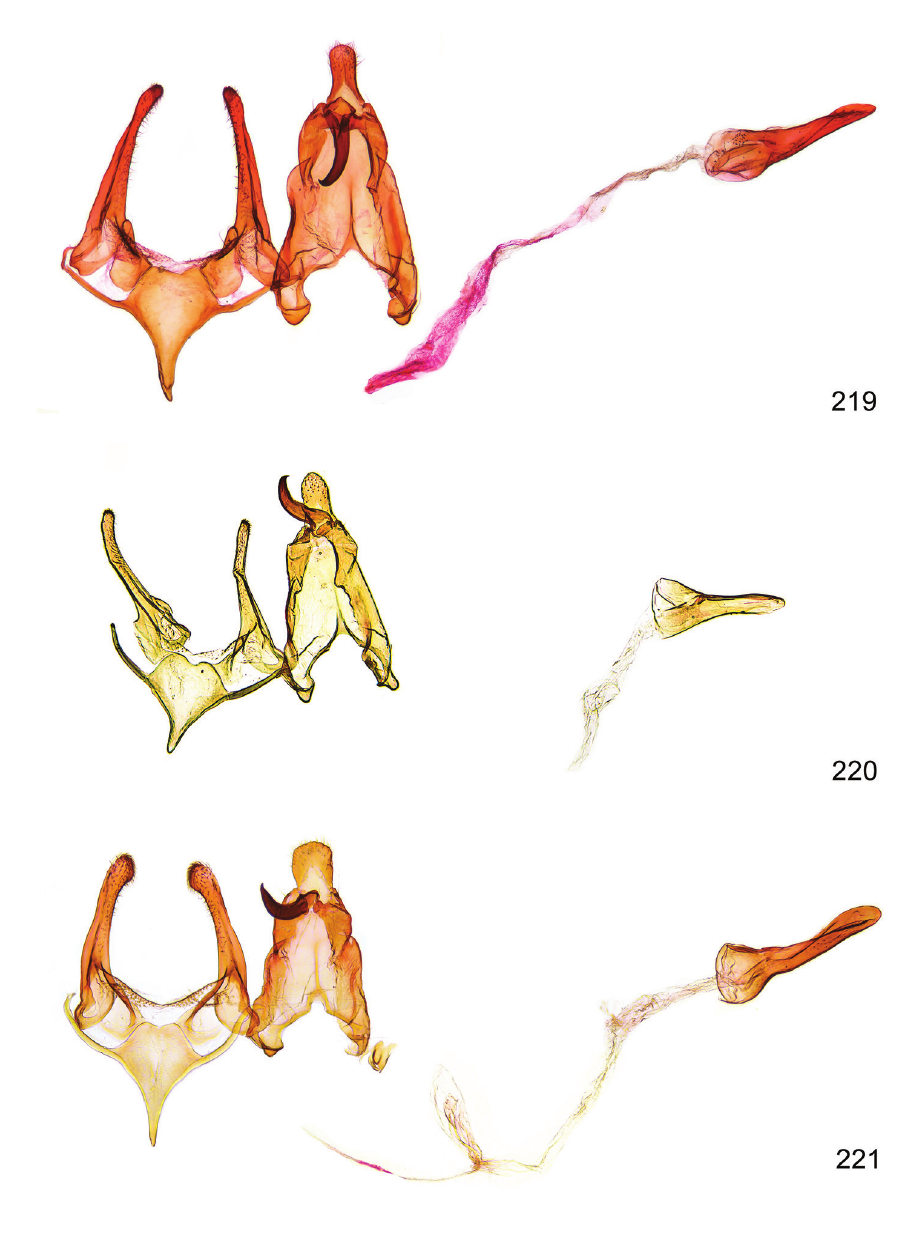
Figures 219–221. Megacraspedus male genitalia. 219 M. balneariellus (Chrétien, 1907) – Croatia, GU 16/1457 P.H. (RCJJ) 220 M. podolicus (Toll, 1942) – Austria, GEL 1202 P.H. (TLMF) 221 M. kazakh- stanicus sp. n. – Holotype, Kazakhstan, GU 17/1496 P.H.